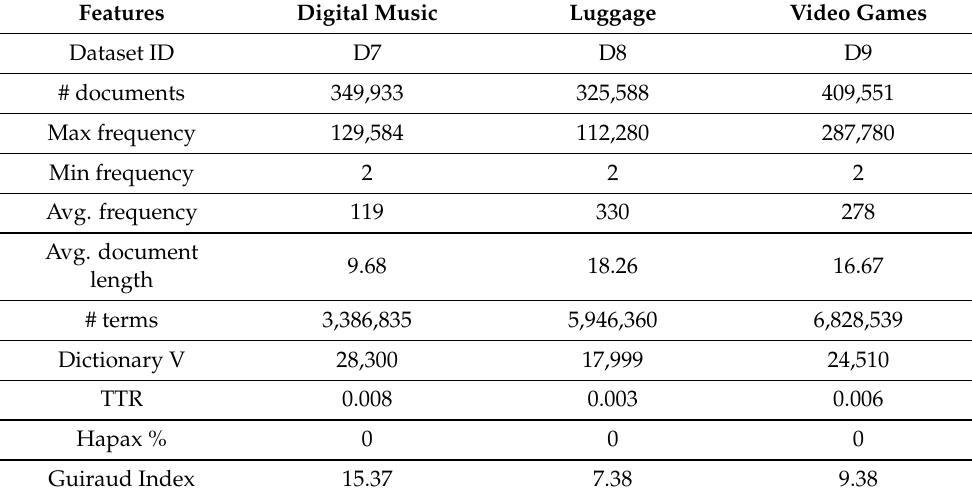
Table 12. Statistical characterization of datasets under analysis.